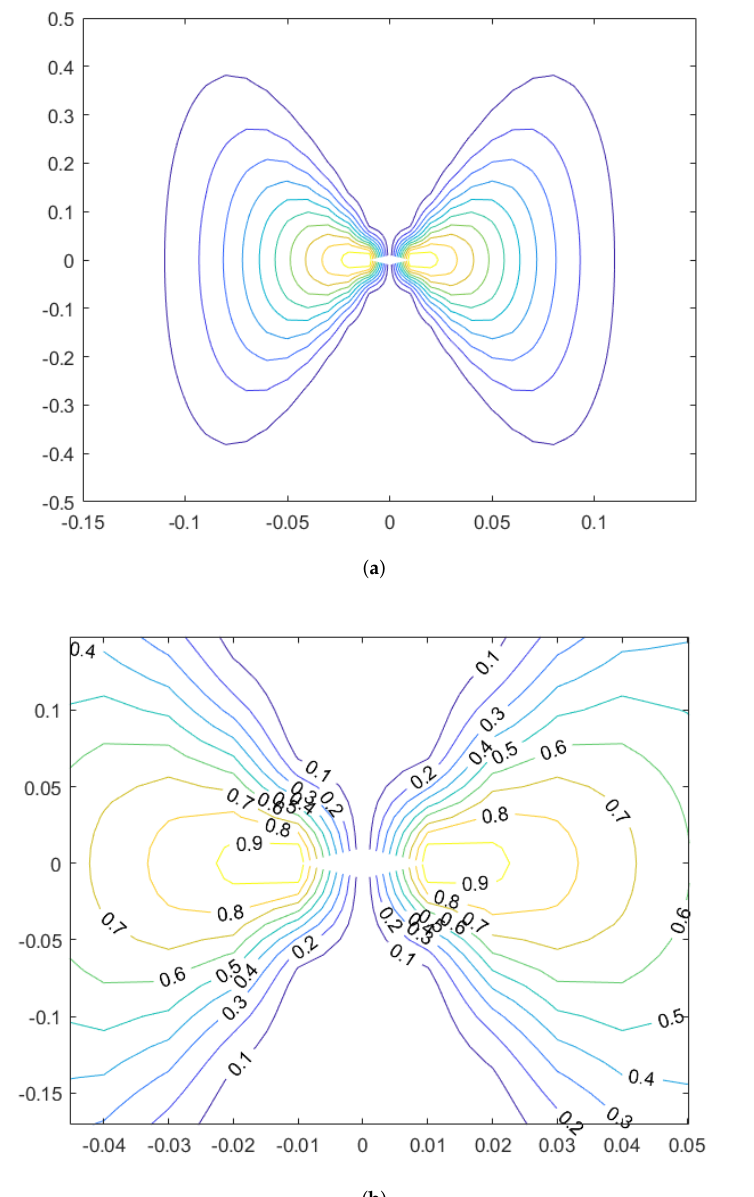
( b ) Figure 2. CTFD’s kernel function contour diagram. ( a ) The contour diagram at γ = 0.0005 and ξ = 0.025; ( b ) Local amplification